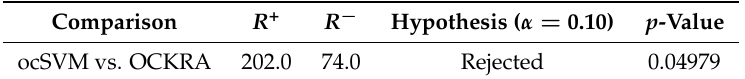
Table 10. Wilcoxon signed-ranks test comparison between AUC obtained respectively by ocSVM and OCKRA classifiers when using the DS-2 dataset.